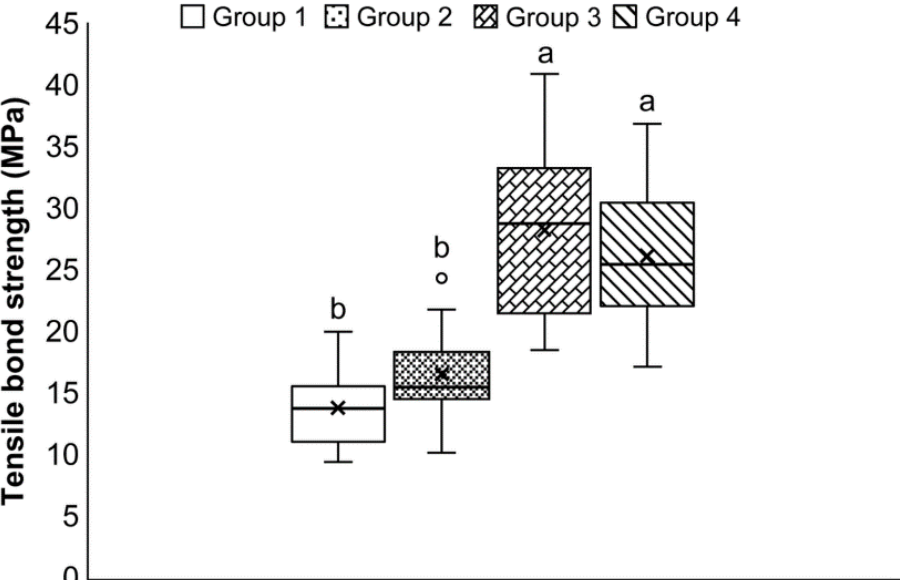
Figure 1. Box plot of shear bond strength (MPa) of samples belonging to Groups 1–4. The different letters represent significant differences between the groups ( p < 0.05).